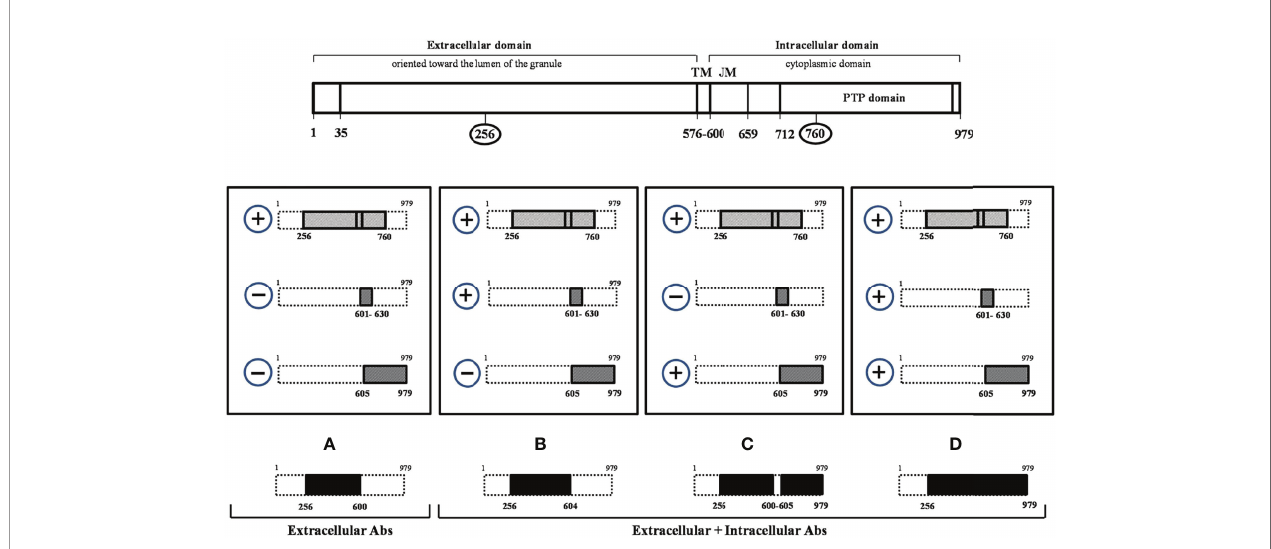
FIGURE 1 | Tyrosine phosphatase 2 (256-760) immunoreactivity dissection study. At the top of the fi gure the tyrosine phosphatase 2 (IA-2) full-length protein (a.a.1- 979) is schematically represented. The four rectangles in the central part of the fi gure indicate all possible combinations resulting from the analysis of IA-2(256-760) Ab positive sera with IA-2JM(601-630) and IA-2IC(605-979) constructs. In the lower part of the fi gure the IA-2 domains (A – D) resulting by the various patterns of immunoreactivity and that distinguish the extracellular alone from more complex forms of immunoreactivity against IA-2 protein are shown in